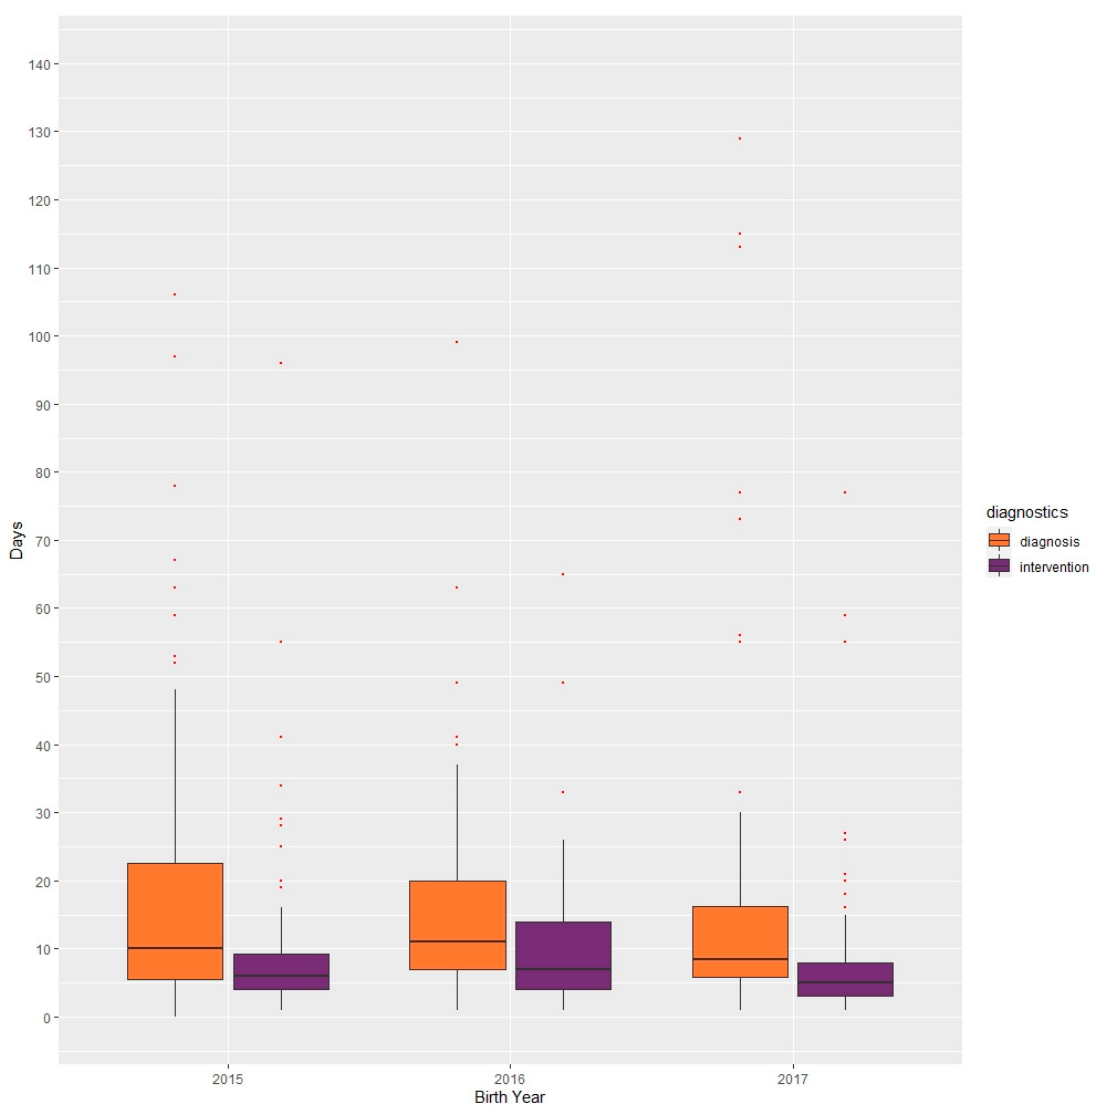
Figure 11. Congenital adrenal hyperplasia cases: time interval from birth to intervention and confirmation of diagnosis, by